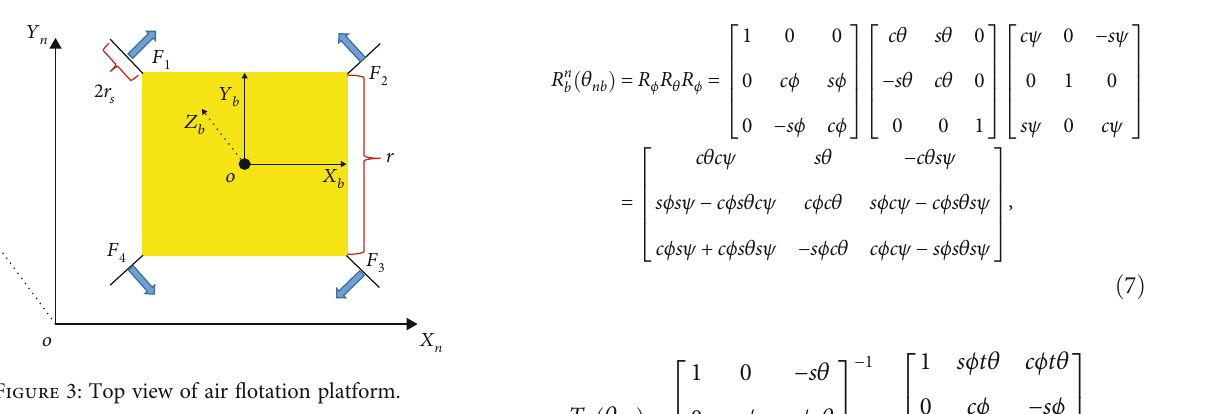
Figure 2: (a) Schematic diagram of space station and ground simulation platform. The AAR-2 is a free fl ying robot used in the space station cabin to assist astronauts in some space missions. This robot can use the microgravity simulation air fl otation platform to simulate the 3- DOF plane motion on the marble table. (b) Actual experimental platform.